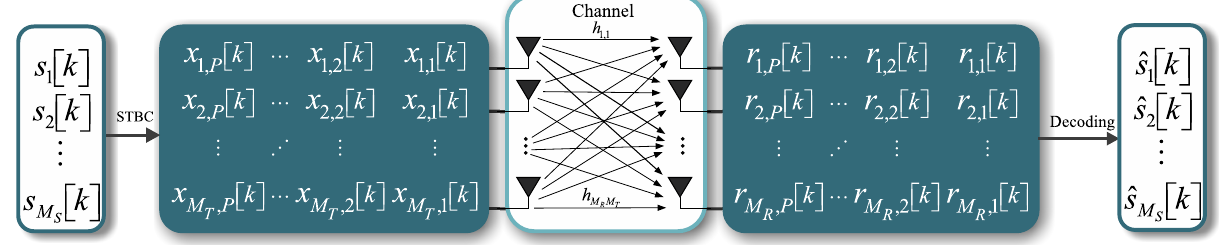
Figure 1. Coding scheme for a MIMO-OFDM system in which k is the index of the k th MIMO-STBC-encoded symbol matrix X [ k ] along the OFDM symbol [11].